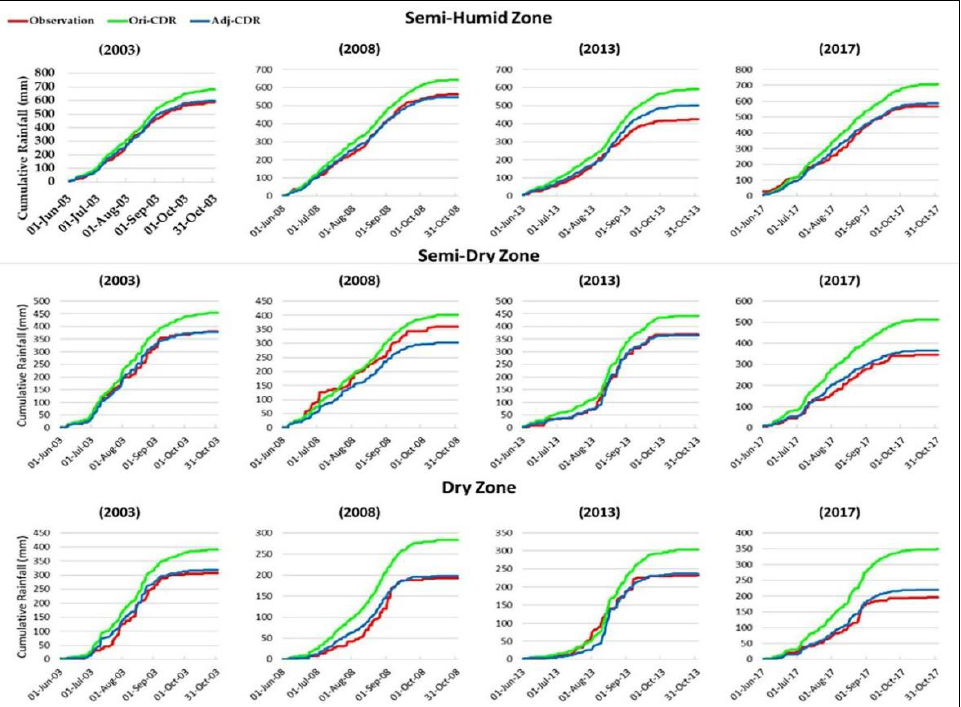
Figure 10. The cumulative rainfall for gauge observation, Ori-CDR, and Adj-CDR.